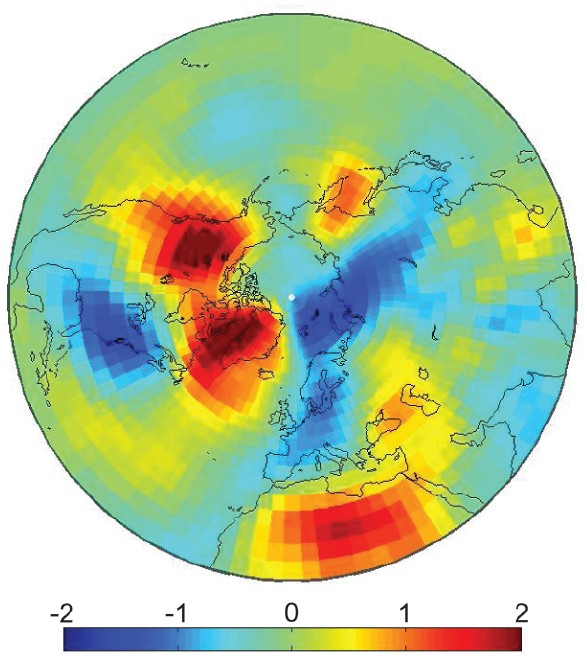
Fig. 8. Mean winter (DJF) 2m temperature difference ( K ) between a 20 year long simulation with ECHAM4 nudged towards a negative NAM index of one standard deviation and a 20 year long control